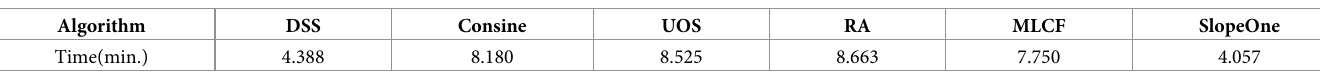
Table 1. The time it takes to compute each method (in minutes) with identical hardware and parameters. Algorithm DSS Consine UOS MLCF